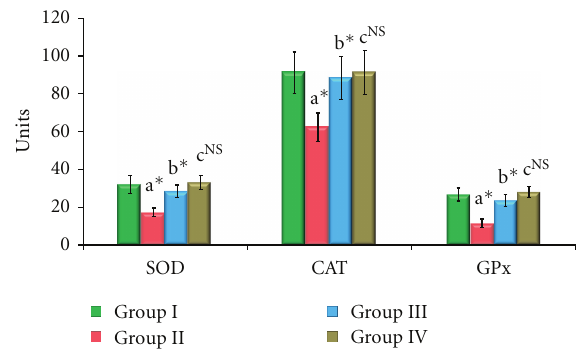
Figure 3: E ff ect of TD on enzymic antioxidants in kidney of control and experimental animals. Values are expressed as mean ± SD for six animals. Comparisons are made between “a” Group II versus Group I, “b” Group III versus Group II, “c” Group IV versus Group I. The symbol ∗ represents the statistical significance at P < 0 . 05. NS: nonsignificant. SOD: U/min/mg protein, CAT: µ moles of H 2 O 2 consumed/min/mg protein, GPx: µ moles of GSH oxidized/min/mg